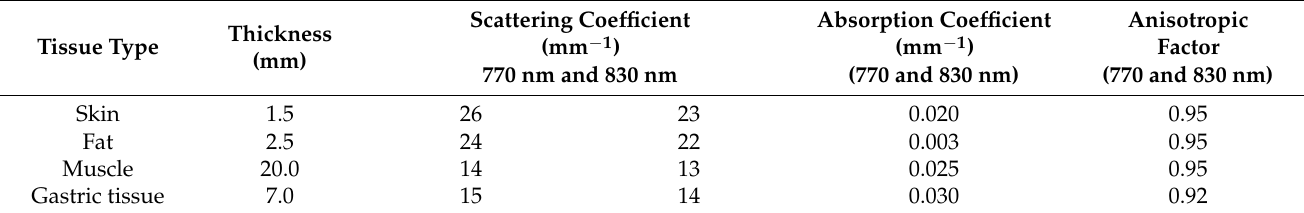
Table 1. Optical properties and layer thickness in simulation